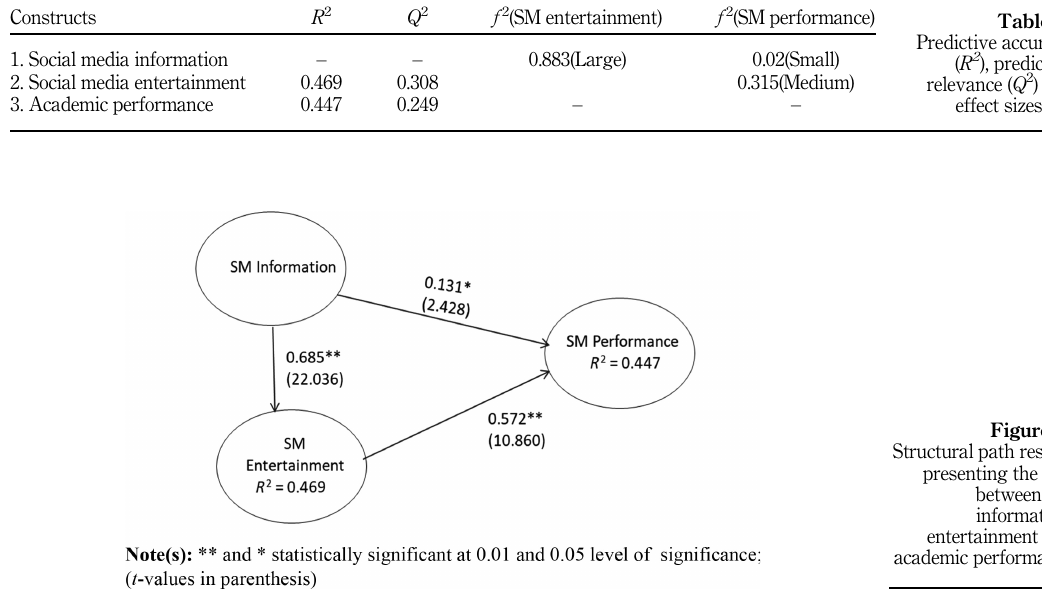
Table 5. Predictive